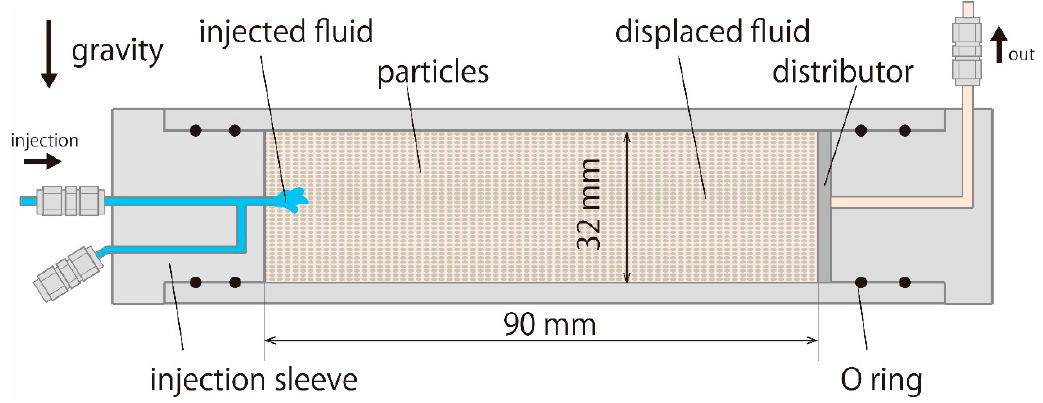
Figure 1. Cross-sectional view of a packed bed of particles. Melamine particles with an average diameter of 338 μ m were packed in a tube with an inner diameter of 32 mm and over 90 mm in height. The diameter of the inlet nozzle is 1.59 mm (1/16 in). A sintered glass plate placed at the exit serves as a distributor.